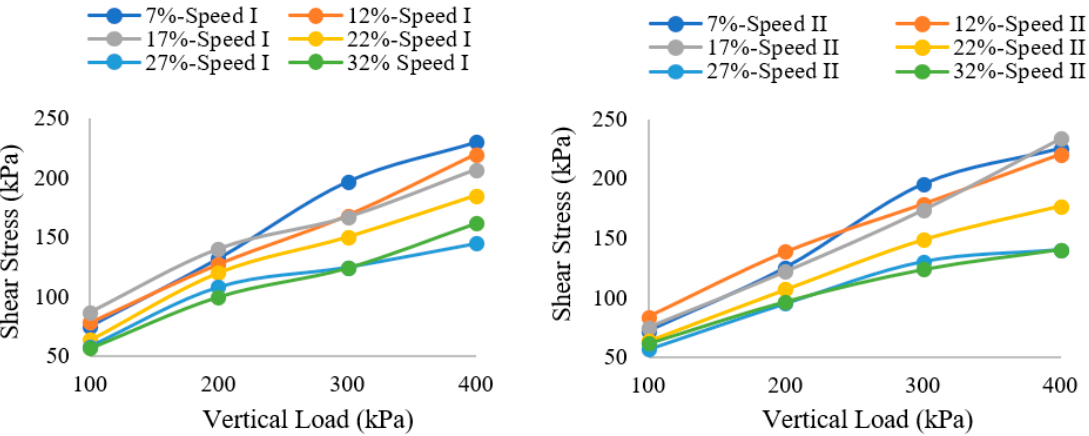
Figure 10. The changing trend of shear stress with the increase in vertical